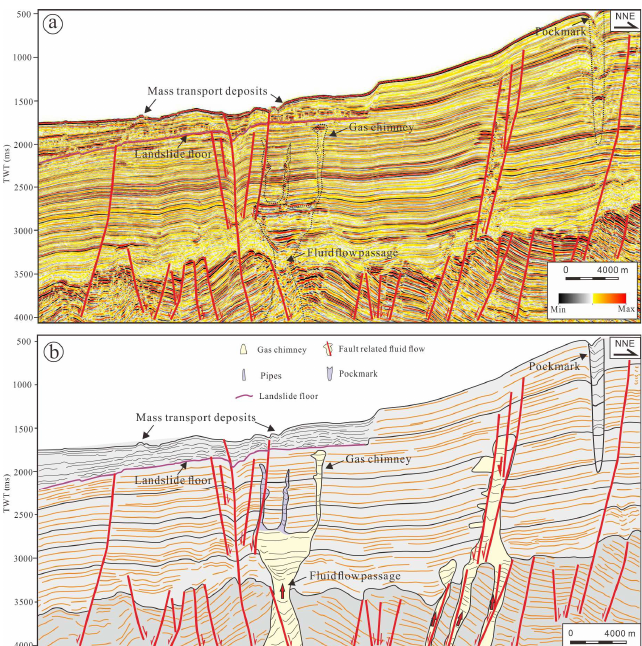
Figure 4. Seismic profile ( a ) and geological interpretation ( b ) showing the pockmark and mass transport deposits with gas chimneys and fluid flow passages in the southern part of the Beikang Basin at the continental margin of the southern South China Sea. A distinct interface of landslide floor marked by the purple line appears at the bottom of the mass transport deposits. A large number of faults have been developed to connect the deep and shallow strata as fluid flow passages. The location of Figure 4 correspond to the red line C in Figure 1.